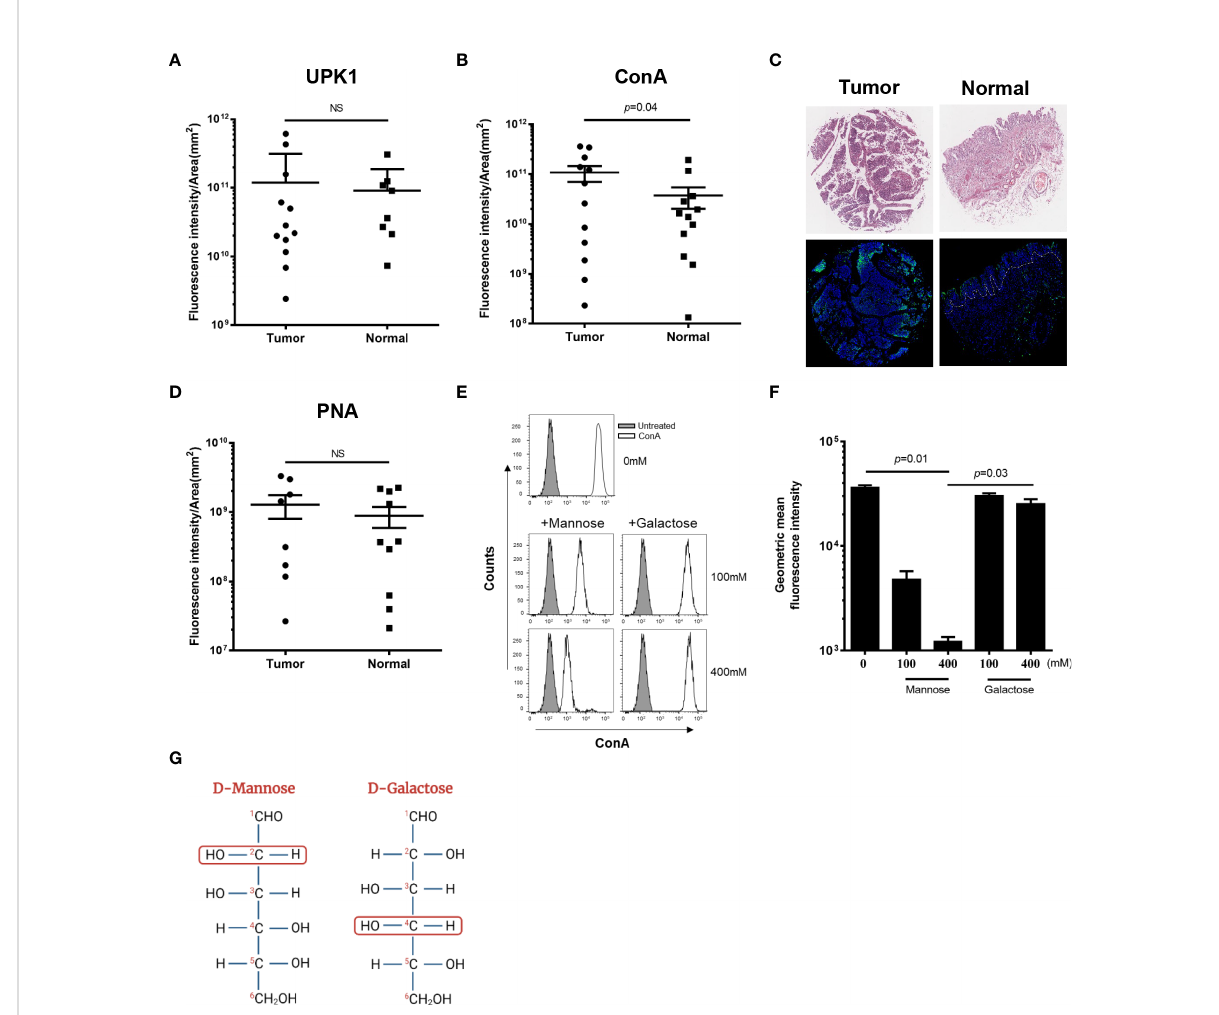
FIGURE 1 Bladder cancer cells express high levels of mannose. Binding of FITC-conjugated UPK1 (anti-uroplakin Ia antibody) (A) , FITC-conjugated ConA (B) , or FITC-conjugated PNA (D) to normal and tumor human bladder cancer samples (TMA BL244a). Each symbol represents one core. Circular symbols represent cancer samples; rectangular symbols represent normal adjacent tissues. Fluorescence intensity was analysed under the same conditions and divided by region of interest (ROI) area (mm 2 ). NS, non-signi fi cant ( p >0.05). Error bars indicate mean with SD. p was calculated using two-tailed Wilcoxon matched-pairs signed rank test. (C) Images of representative stained TMA of human bladder cancer (Tumor) and normal tissue (Normal). Top panel: H&E staining. Bottom panel: Staining with FITC-conjugated mannose-speci fi c ConA (green) and Hoechst dye (blue). Dashed lines indicate the epithelial-muscle border (ROI) in the normal bladder tissue. (E) Representative fl ow cytometry histograms of binding off FITC-conjugated ConA to MB49 cells. ConA staining were measured in the absence (upper panel) or presence of mannose (left, middle and bottom panels) or galactose (right, middle and bottom panels) in the two indicated concentrations (100 mM and 400 mM). Grey fi lled histograms represent untreated MB49 cells. (F) Flow cytometry analysis of attachment of FITC-conjugated ConA (160 nM) to the MB49 murine bladder cancer cell line in the absence ( fi rst left column) or presence of the indicated concentrations of mannose or galactose. Mean ± SEM of six independent experiments performed in triplicate are presented. p was calculated using Bonferroni corrected one-tailed Wilcoxon matched-pairs signed rank test. (G) Schematic illustration representing the con fi guration differences between the epimers D-Mannose (on the left) and D-Galactose (on the right). The second (in D-Mannose) and fourth (in D- Galactose) carbon groups are surrounded by red un fi lled circles to emphasize the